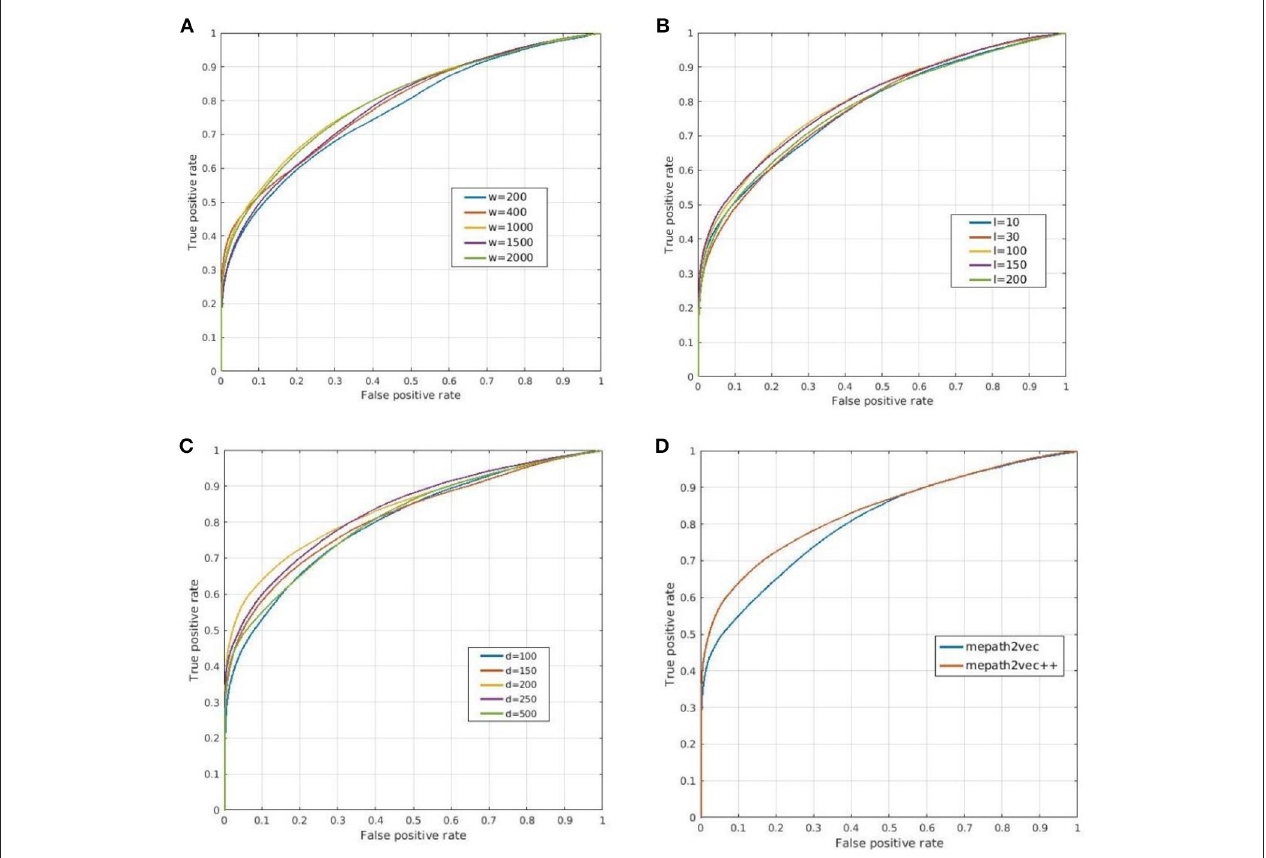
FIGURE 7 | Prediction results obtained by (A–C) varying three parameters and (D) comparing metapath2vec and metapath2vec ++ . (A) ROC curves for changing w that indicates the numbers of walkers in the random walk algorithm. (B) ROC curves for changing l that indicates the lengths of the metapath in the random walk process. (C) ROC curves for changing d that indicates the dimensions of the representation vector. (D) ROC curves for comparisons of metapath2vec and metapath2vec ++ . TABLE 1 | AUROC values for three varying parameters.